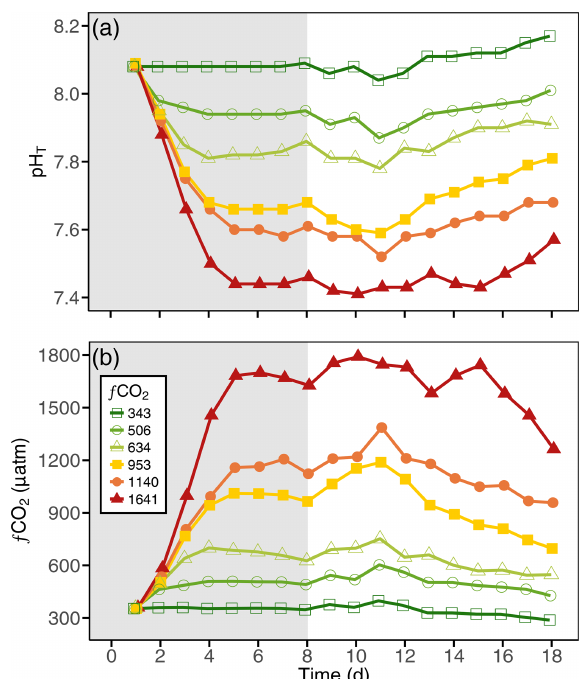
Figure 4. The (a) pH on the total scale (pH T ) and (b) fugacity of CO 2 ( f CO 2 ) carbonate chemistry conditions in each of the mini- cosm treatments over time. Grey shading indicates CO 2 and light acclimation